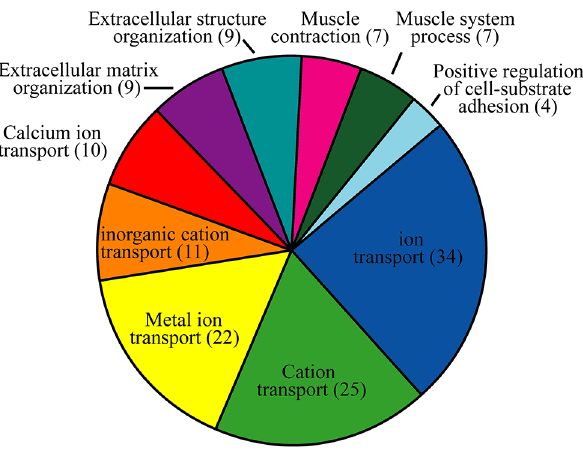
Fig 4. Enriched biological process GO term among differentially expressed genes. Numbers in parentheses indicate the number of differentially expressed genes.